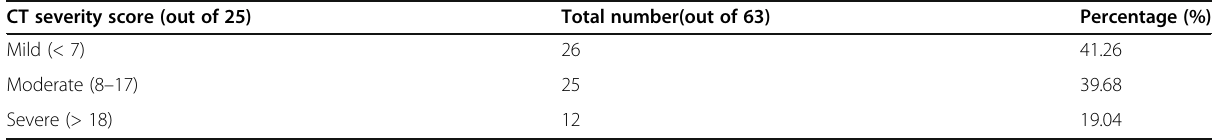
Table 5 Atypical features of COVID-19 cases and their CT severity score CT severity score (out of 25)